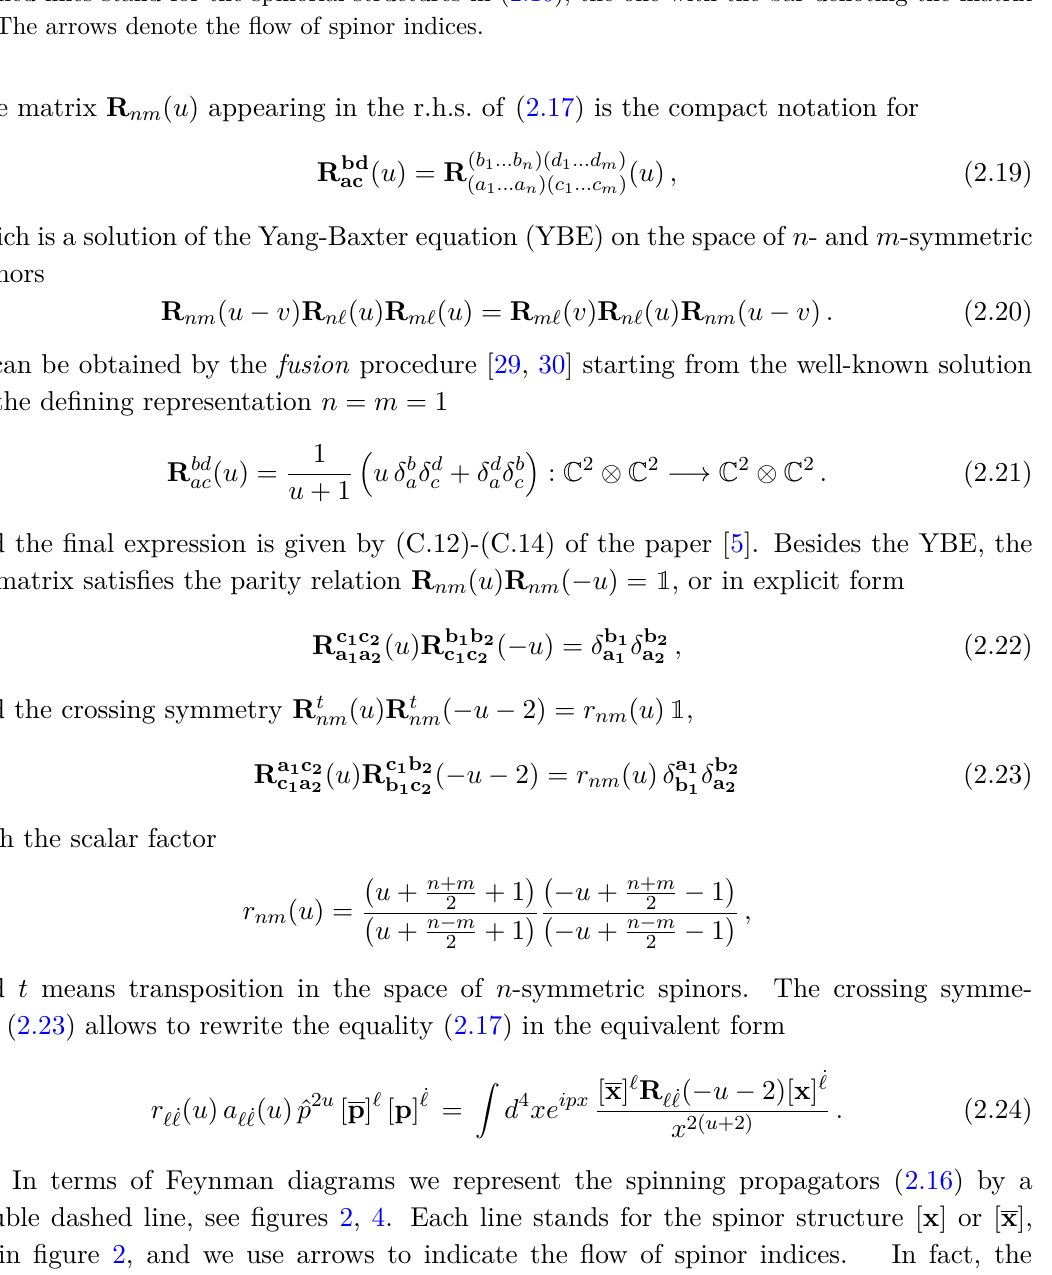
Figure 2 . Graphic representation of the propagator G dimension β = − u and spins ( ‘, ˙ ‘ ) = (0 , ˙ ‘ ) — first row — or ( ‘, ˙ ‘ ) = ( ‘, 0) — second row. The dashed lines stand for the spinorial structures in (2.16), the one with the bar denoting the matrix x . The arrows denote the flow of spinor